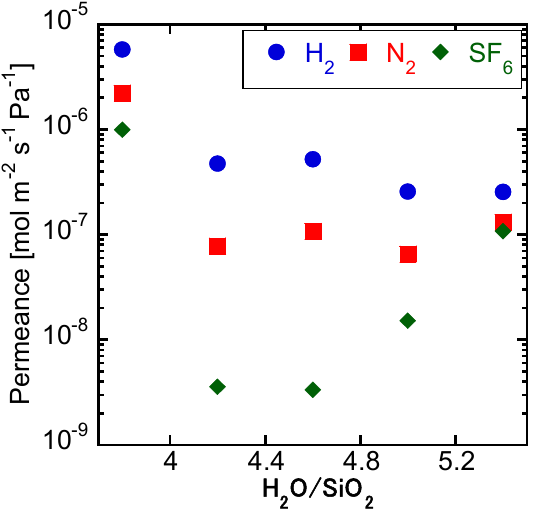
Figure 4. Single gas permeances through the membranes crystallized with varying H 2 O/SiO 2 . (1 SiO 2 :0.8 TMAdaOH:0.8 HF:X H 2 O, 0.01 wt% CHA seeds, 16 h at 423 K).